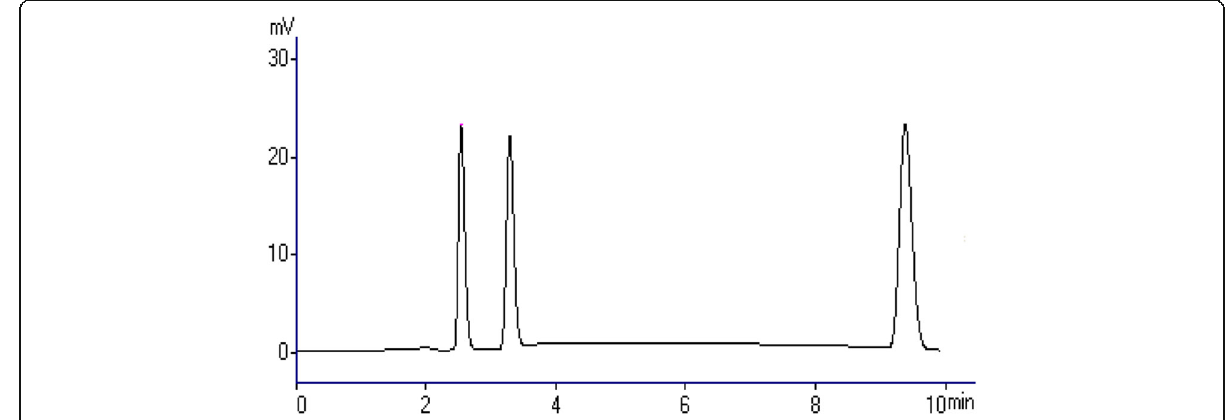
Fig. 2 Representative chromatogram of quinolone, cetirizine, and internal